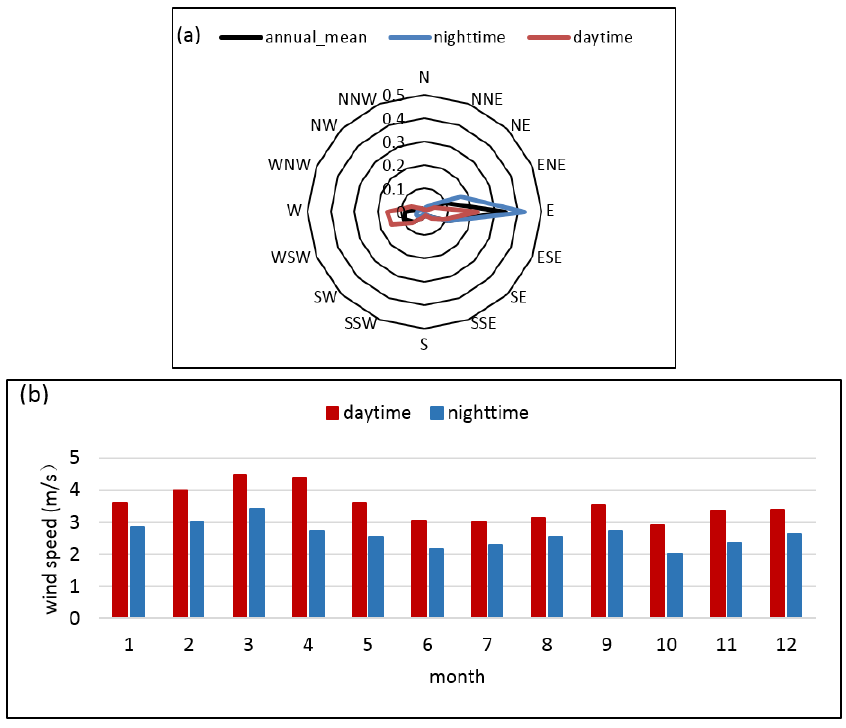
Figure 3. Climatological ( a ) wind roses and ( b ) monthly wind speeds observed at 10 m from meteorological station in Guazhou for the period 2005 – 2012.